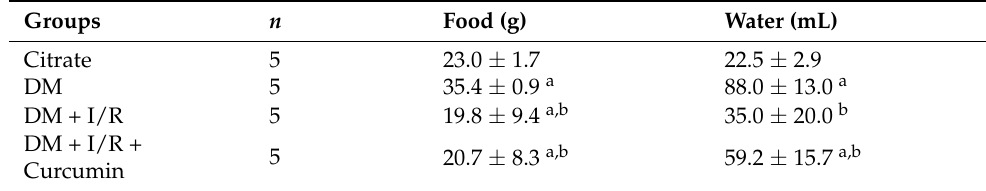
Table 4. Food and water